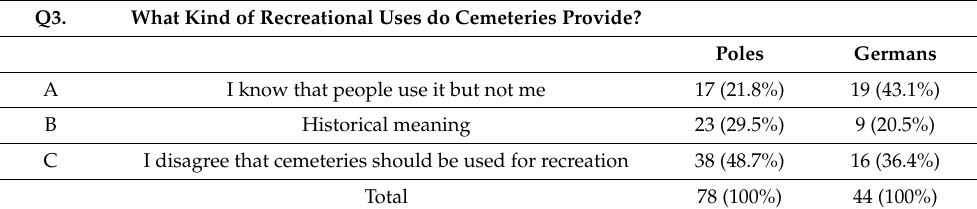
Table 4. Respondents’ opinion on selected cemeteries’ usage in Ł ó d´z and Leipzig.